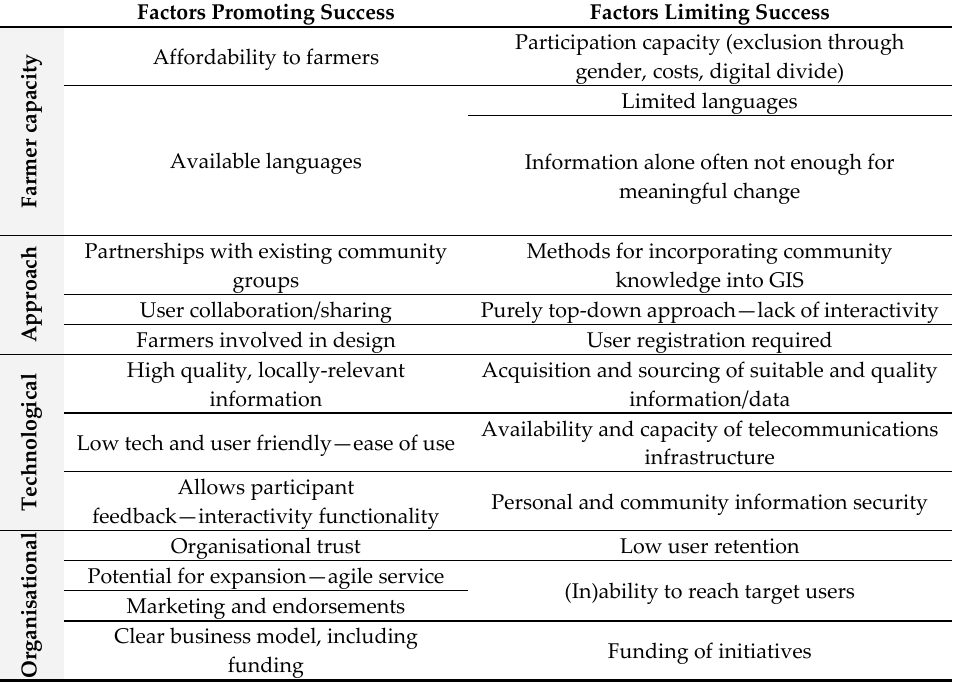
Table 2. Summary of factors promoting and limiting the success of AGI initiatives for addressing key agro-climatic challenges.